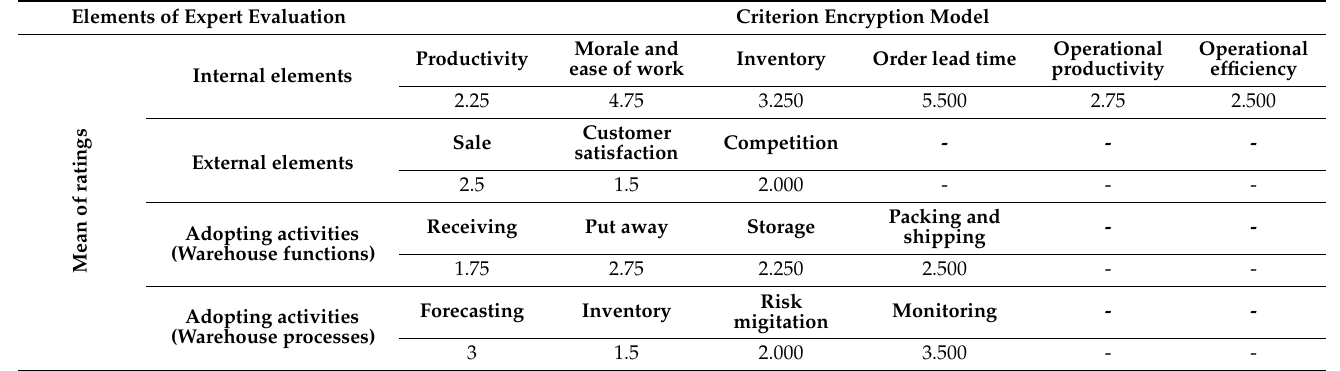
Table 8. The results of the average of the ranks of the expert assessment.